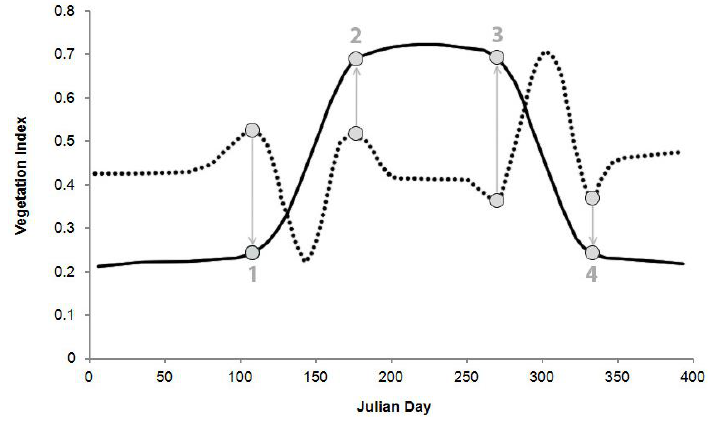
Figure 2. Four transition dates based on the EVI curvature-change rate from the MODIS data time series. The solid line is an ideal time series for the vegetation index data, and the dashed line is the rate of change in the VI data curvature. The circles indicate transition dates: 1: start-of-season (SOS); 2: start-of-maximum (SMAX); 3: end-of-maximum (EMAX); and 4: end-of-season (EOS), adapted from Figure 2 in